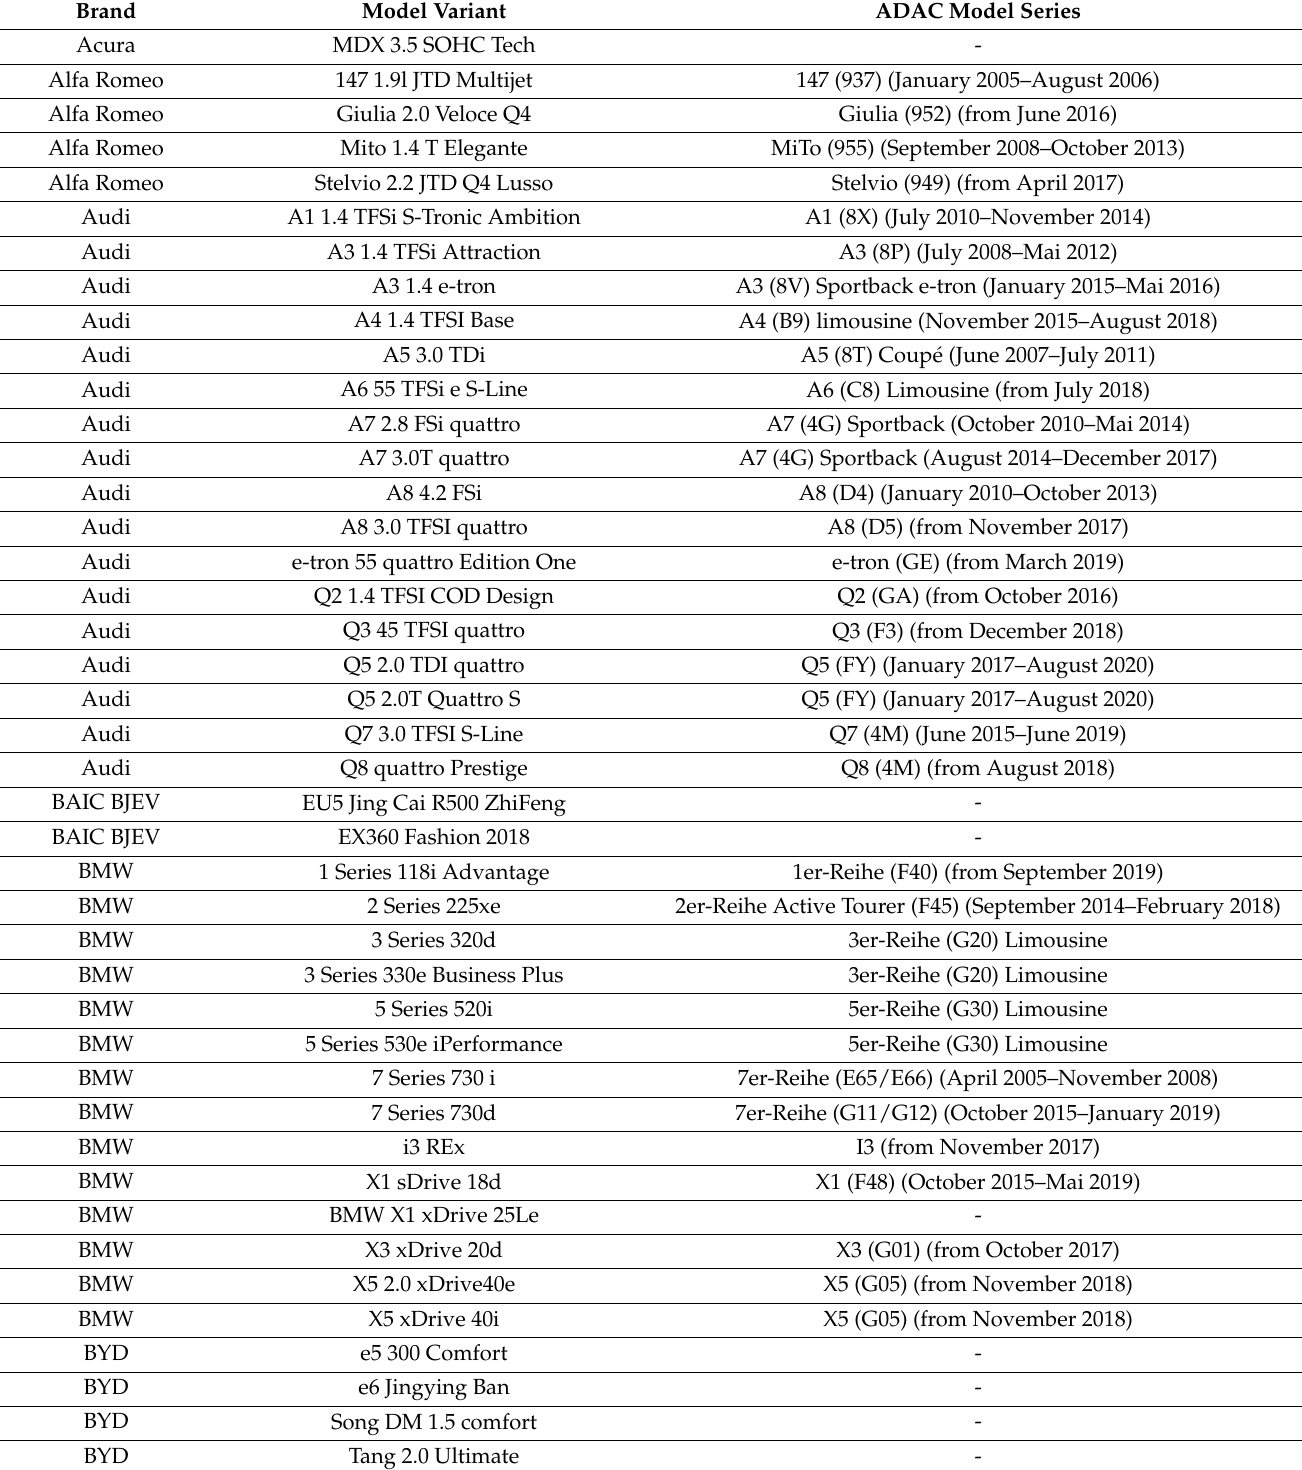
Table A10. Overview of the employed vehicles for the parametric mass model (Part